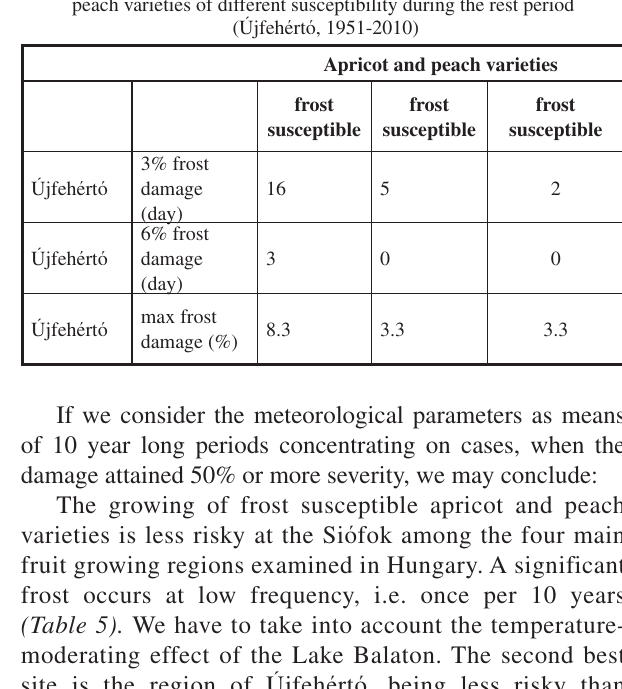
Table 4 – Occurrence of frost damage of increasing severity in apricot and peach varieties of different susceptibility during the rest